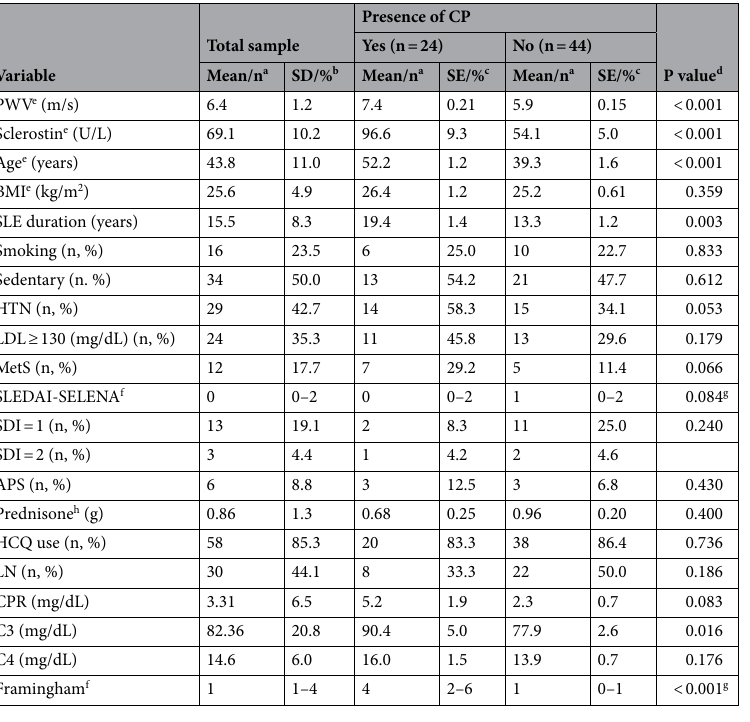
Table 1. Distribution of study variables in the whole sample and according to CP status. CP carotid plaque, SD standard deviation, SE standard error, PWV pulse wave velocity, BMI body mass index, HTN hypertension, LDL low density lipoprotein, MetS metabolic syndrome, SLEDAI-SELENA Systemic Lupus Erythematosus Disease Activity Index, SDI Systemic Lupus International Collaborating Clinics/American College of Rheumatology Damage Index, APS antiphospholipid syndrome, HCQ hydroxychloroquine, LN lupus nephritis, CPR C-reactive protein. a Mean values (for continuous variables)/number of subjects (for categorical variables); b SD (for continuous variables)/%: percent of cases in the sample (for categorical variables); c SE (for continuous variables)/%: percent of cases in each category of CP (for categorical variables); d p values of Student’s t test for independent samples (for continuous variables), p values of chi square test (for categorical variables); e Continuous variables; f Median and interquartile range is shown for these variables; g p value of Mann–Whitney U test; h Glucocorticoids accumulated during the last